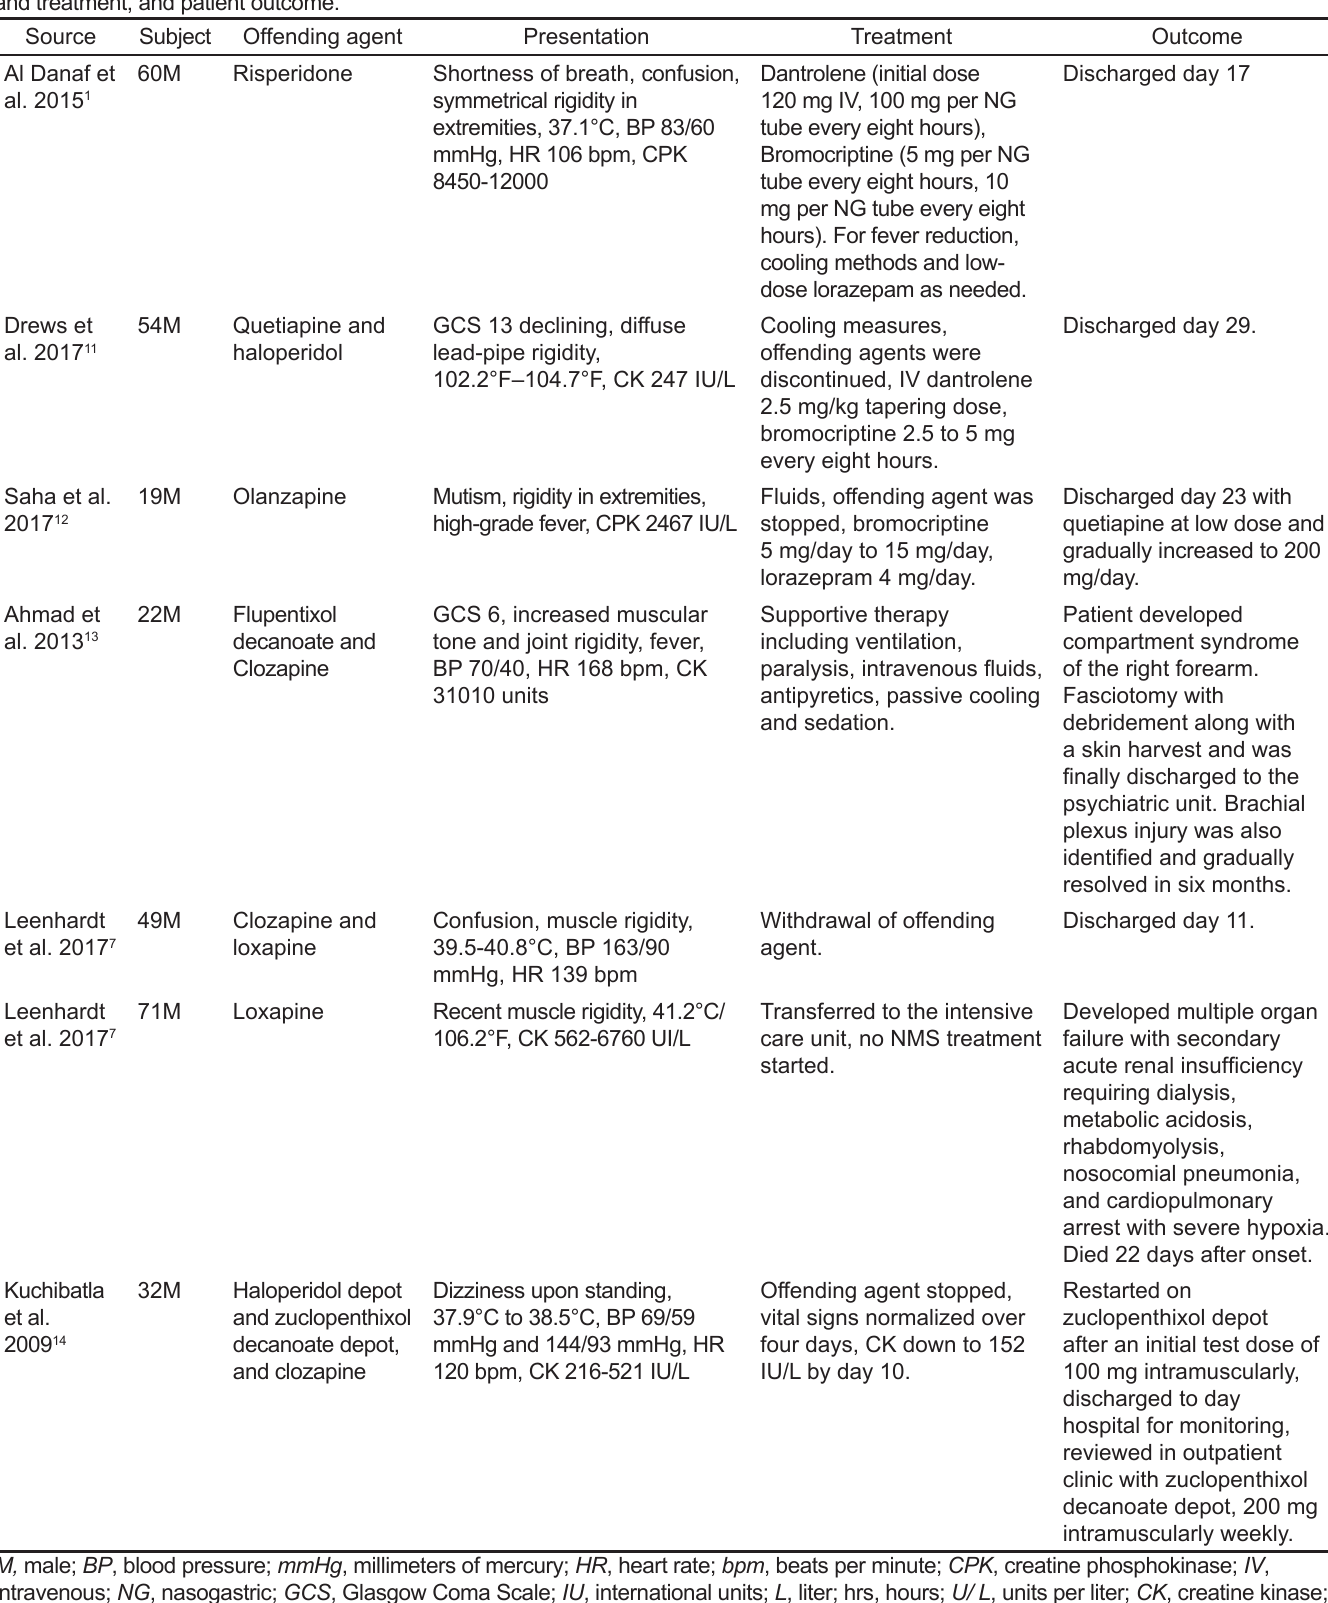
Table 2. Previously published case reports detailing subject’s age and gender, offending agent, neuroleptic malignant syndrome presentation and treatment, and patient